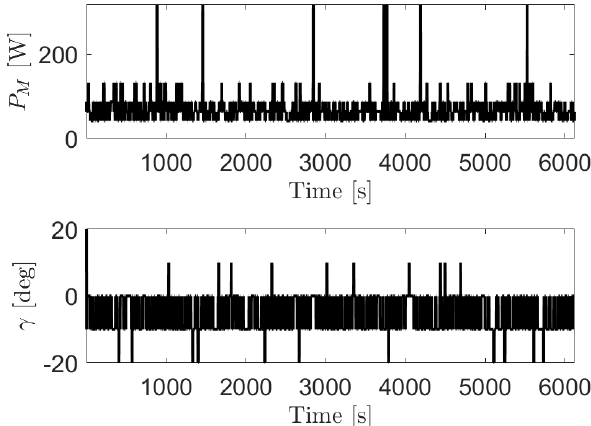
Figure 11. sUAV P M and γ versus time, Simulation Scenario II.